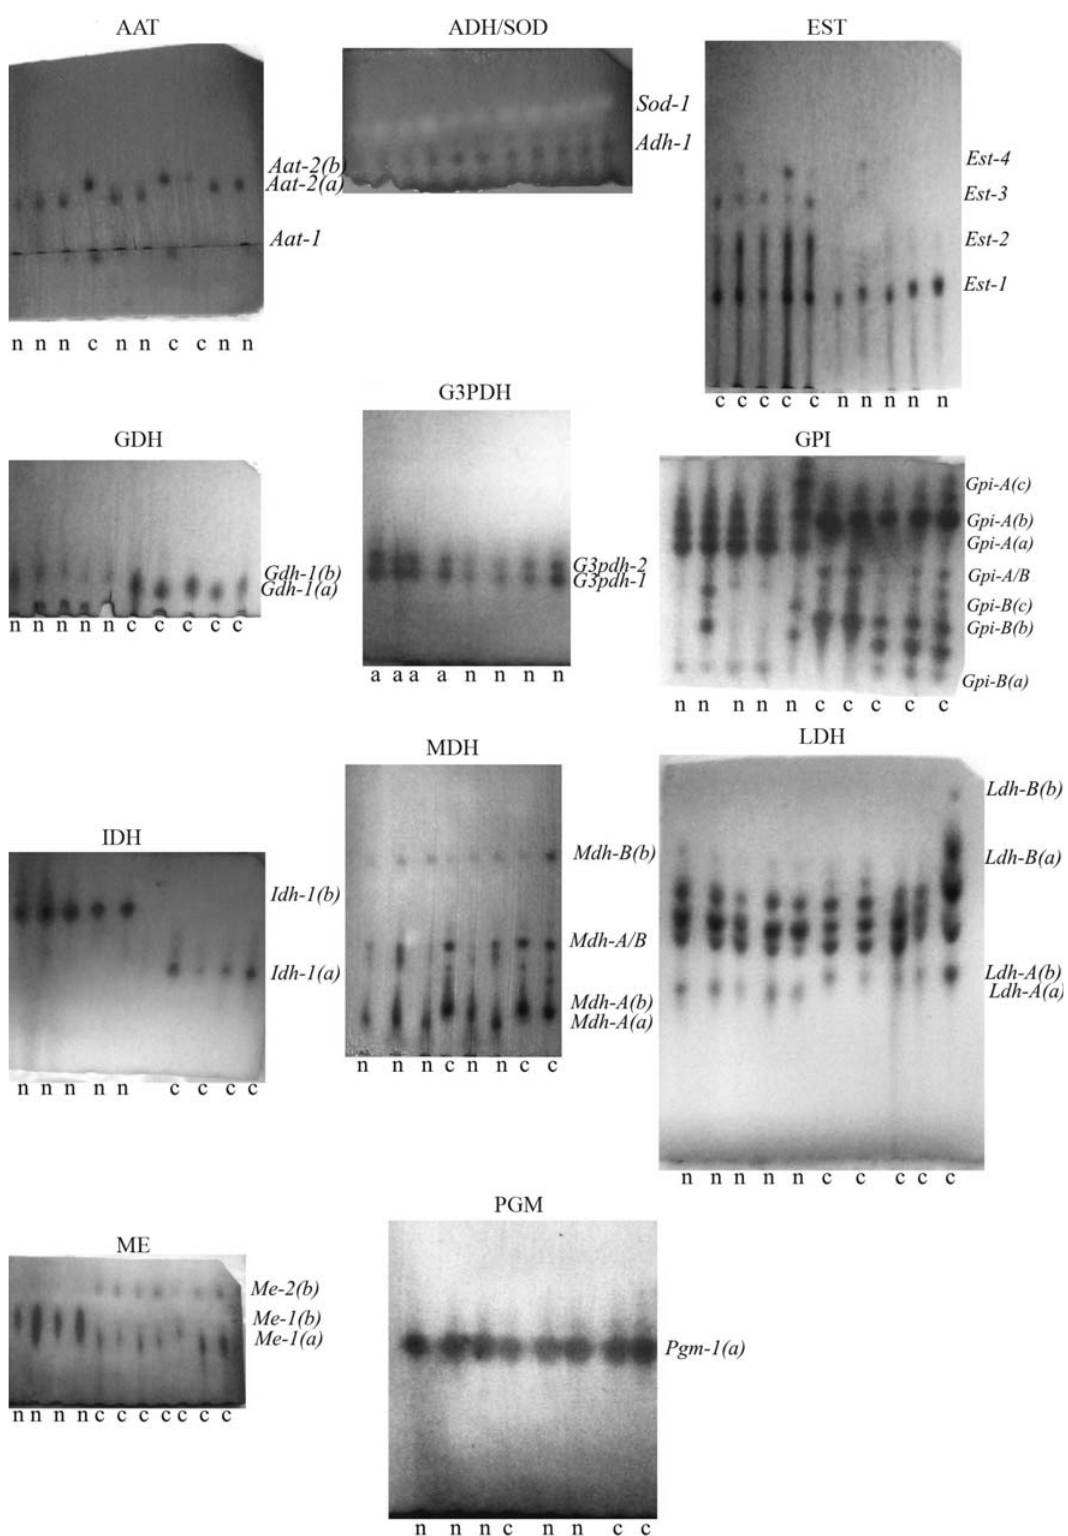
Figure 4 - Electrophoretic patterns of 12 enzyme system analyses in corn starch gel for two morphotypes from the Atlântico Stream, Paraná State, Brazil. n = Hypostomus nigromaculatus ; c = Hypostomus cf. nigromaculatus